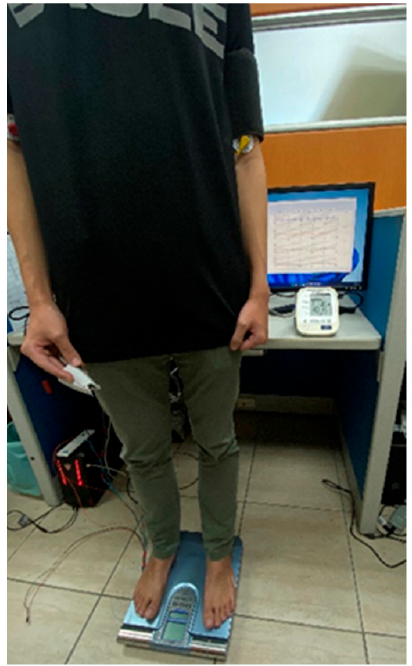
Figure 5. A photo from this experiment shows a subject standing on a commercial body weight-fat scale. The finger of right hand wears the PPG probe, a cuff is wrapped around the left arm, and two electrodes of the ECG are placed on the right and left arms.